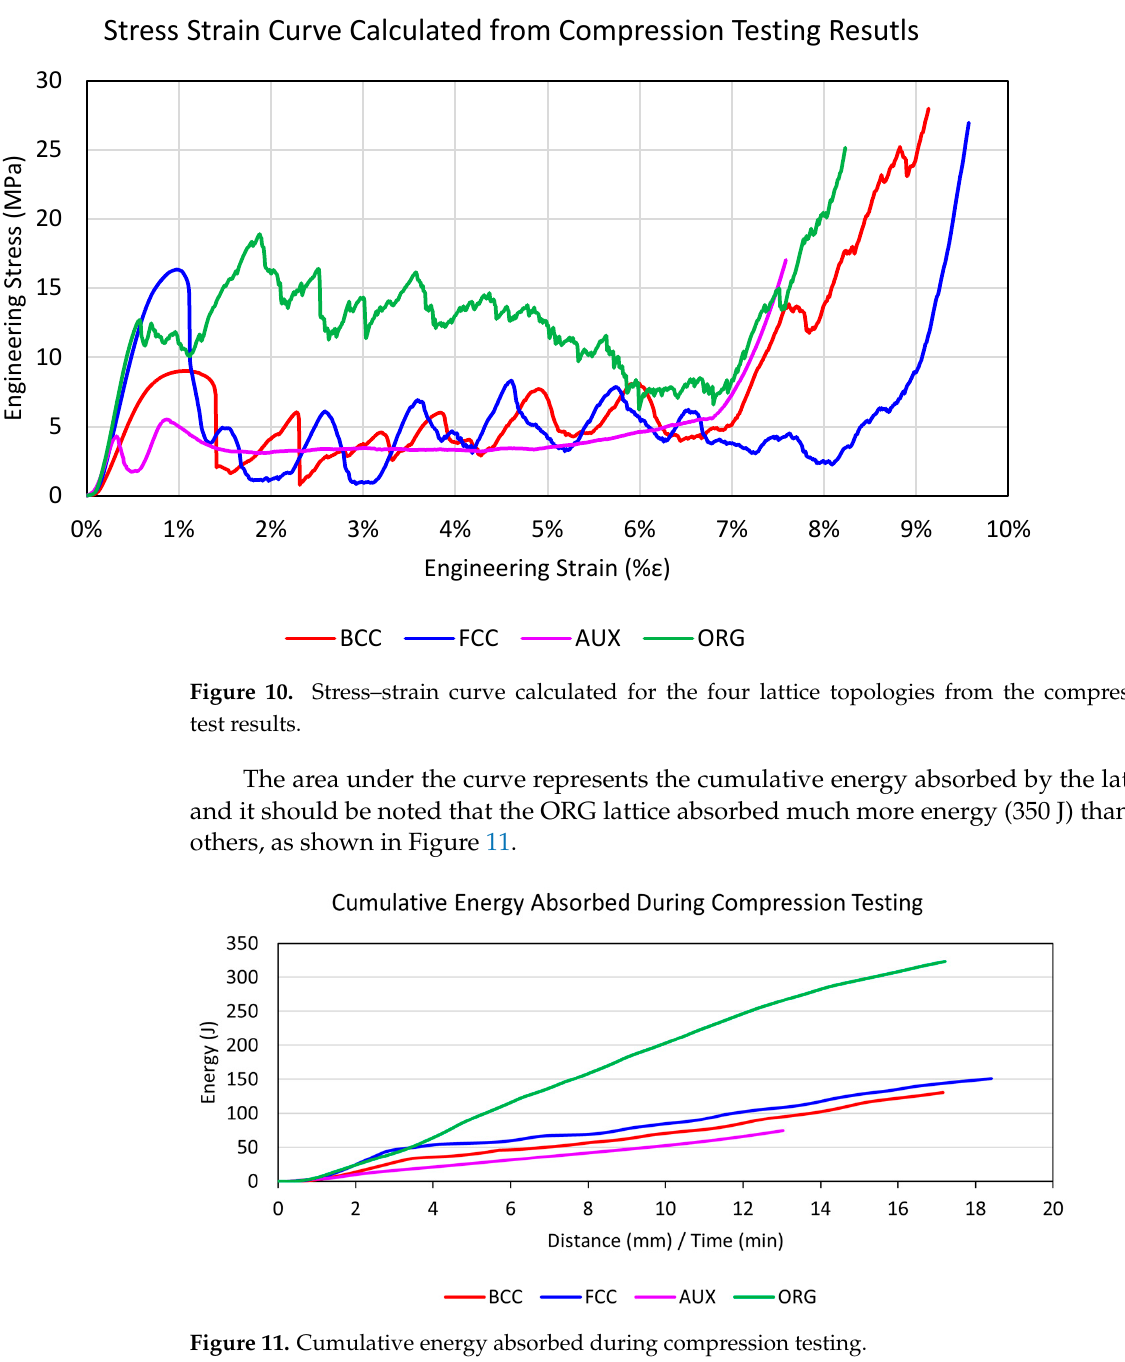
Table 8. Summary of Young’s moduli for the four lattice topologies from mechanical test